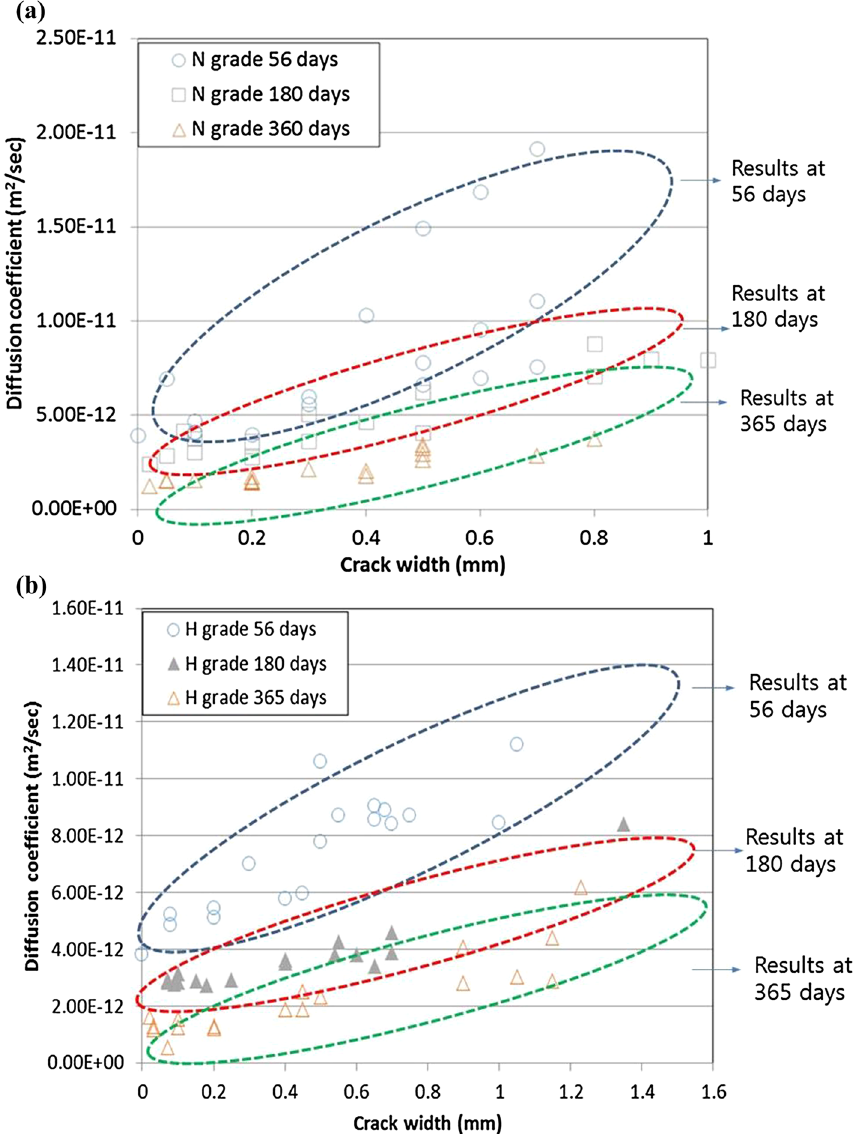
Fig. 4 Changes in diffusion coefficient under steady state condition with various crack width. a Enlarged diffusion coefficient in cracked concrete (N grade). b Enlarged diffusion coefficient in cracked concrete (H